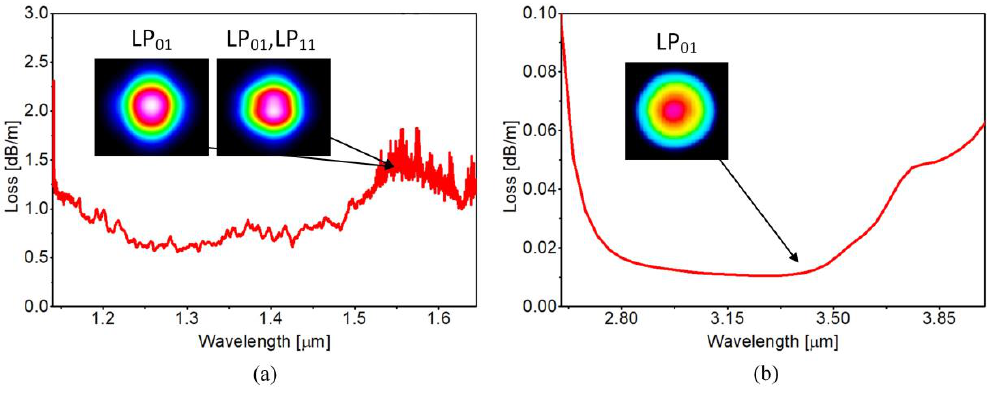
Figure 2. Attenuation spectra of the fabricated ARHCF within: ( a ) Near-Infrared (measured); ( b ) Mid-Infrared (simulated) spectral regions. Near-field fiber-delivered beam profiles captured at 1.574 µm (LP 01 and mixture of LP 01 and LP 11 modes) and 3.334 µm (LP 01 mode) are presented as insets.